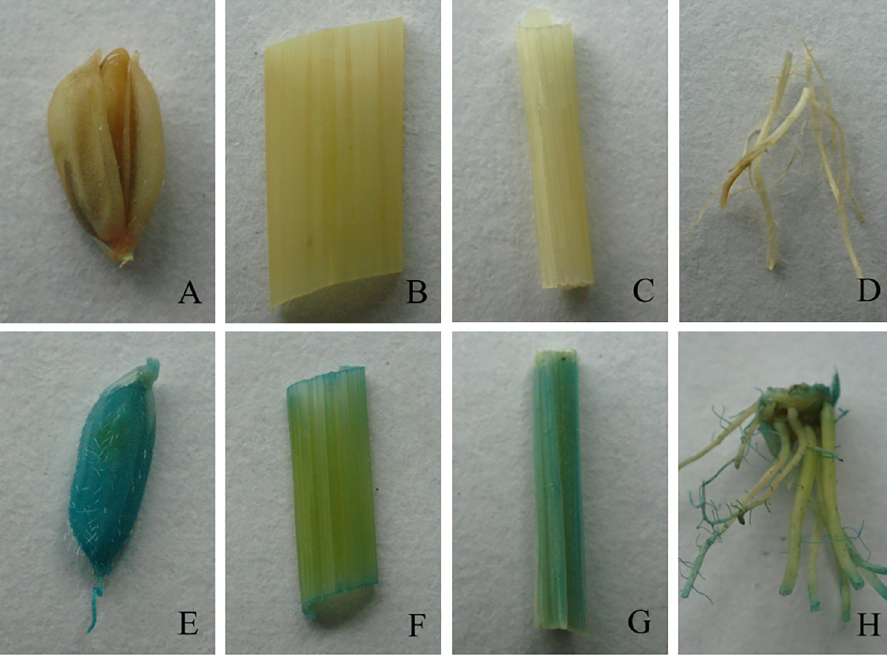
Fig 1. Staining showed expression patterns of OsCYP2 indicated by the GUS reporter gene which was driven by the promoter of OsCYP2 . A-D: seed, leaf, stem and root of wild type; E-H: seed, leaf, stem and root of the p OsCYP2 : GUS transgenic plants.